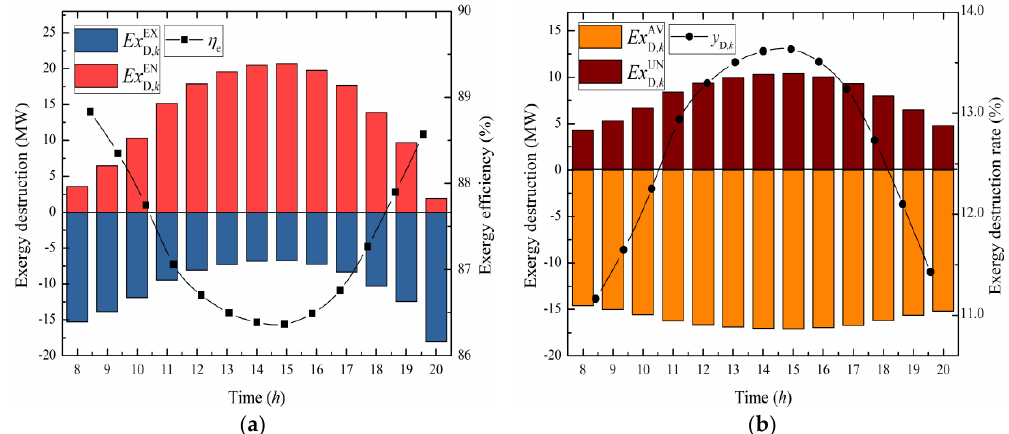
Figure 8. The exergy destruction, exergy efficiency and exergy destruction rate of steam turbines variation with time. ( a ) The endogenous/exogenous exergy destruction and exergy efficiency variation with time. ( b ) The avoidable/unavoidable exergy destruction and exergy destruction rate variation with time.